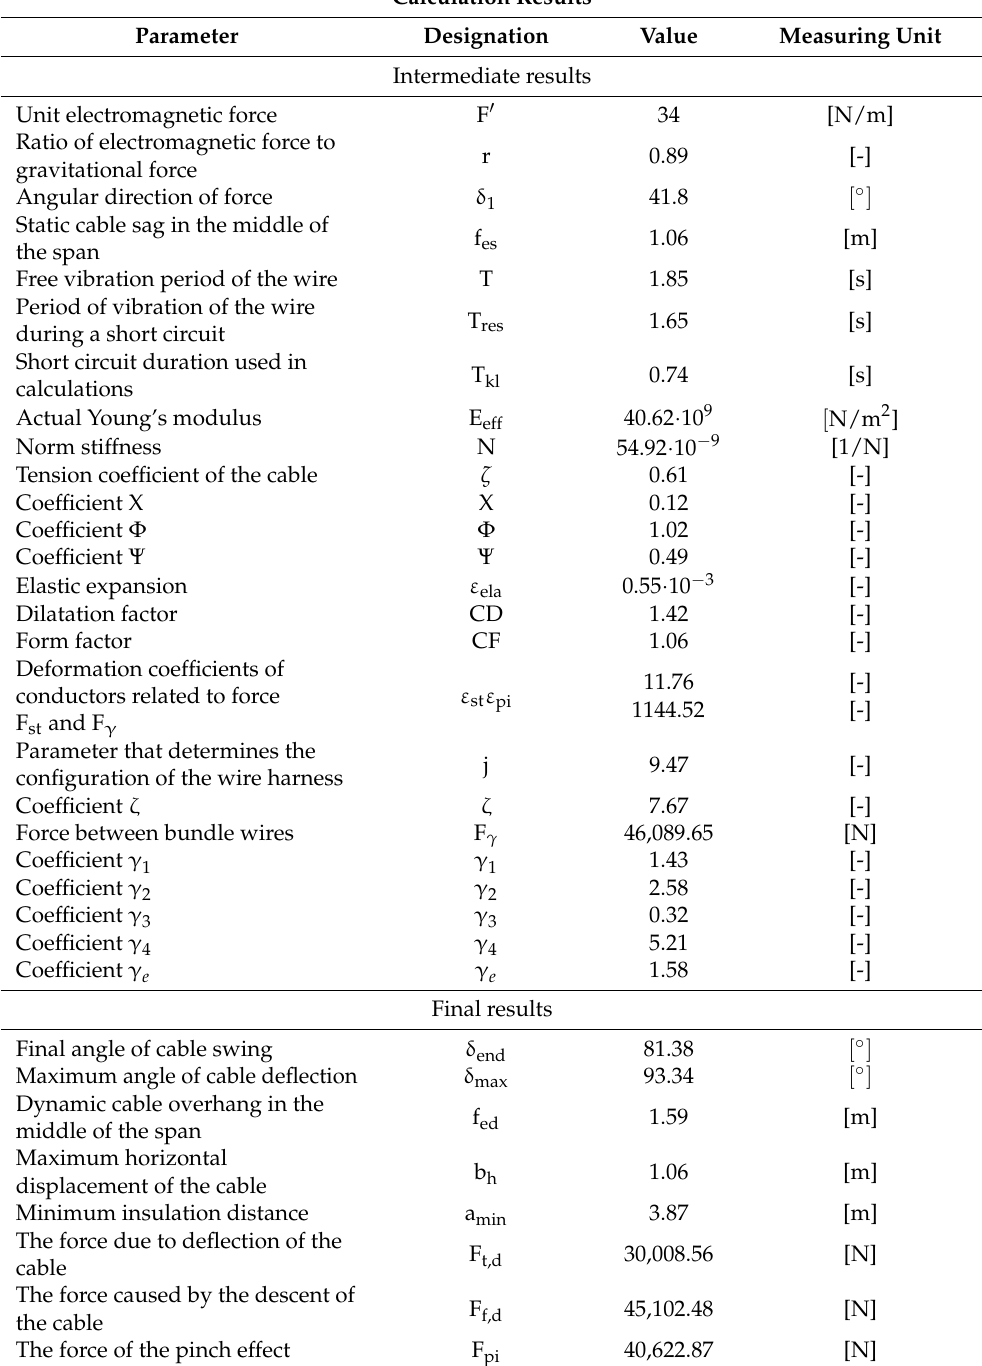
Table 2. Calculation of dynamic effects of short-circuit current; connection made with flexible conductors. Variant I. Results of calculations by the PRIMTECH 3D